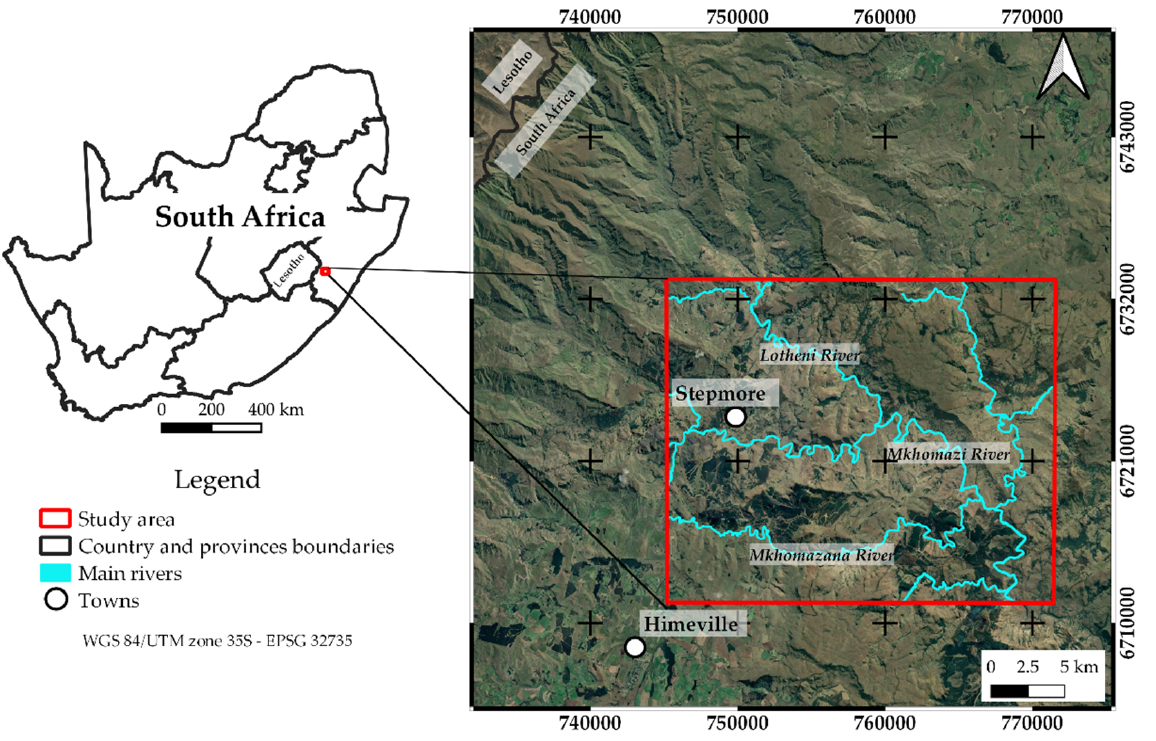
Figure 1. Study area in the upper Mkhomazi River catchment. The region is characterized by a subtropical highland climate (Cwb), according to the Köppen climate classification [58]. The average rainfall amounts to 920 mm/year based on the 1970–2005 precipitation time series [59]. The most common land use is stock grazing of the grassland that covers approximately 66% of the study area, followed by thickets or shrubland covering 7% and commercial afforestation ( Pinus patula and Eucalypts) covering 6% (Figure 2b)